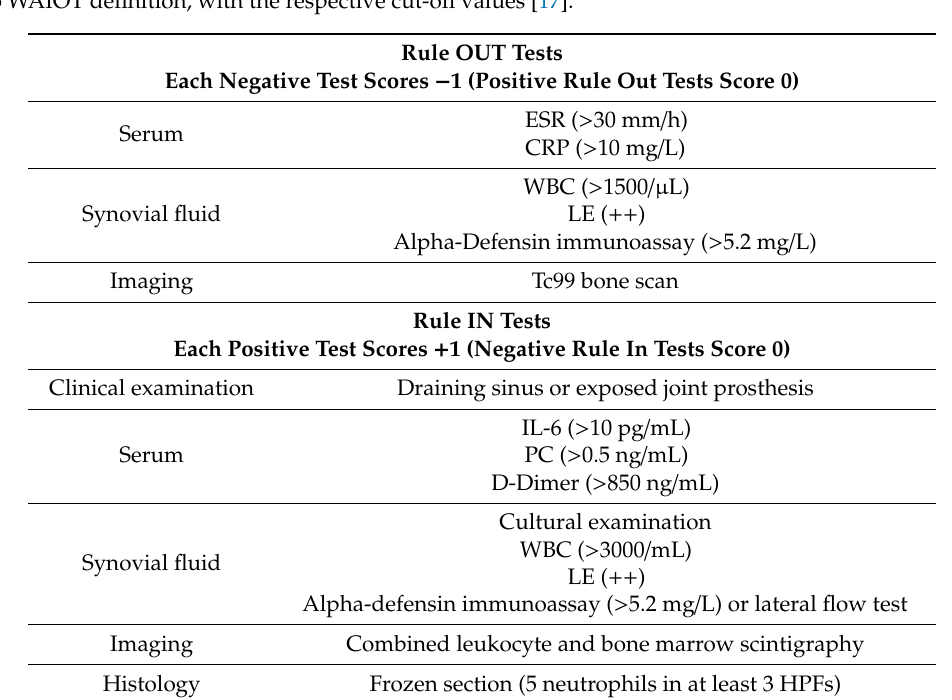
Table 3. Pre / intra-operative tests used to exclude (“rule out”) or to confirm (“rule in”) a PJI according to WAIOT definition, with the respective cut-o ff values